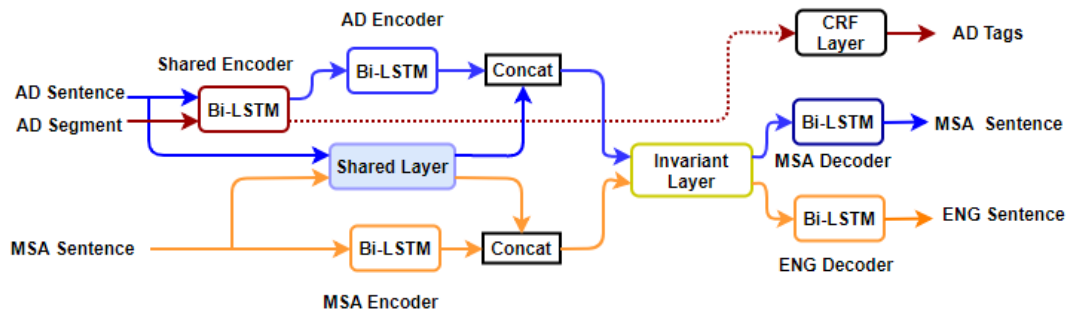
Figure 2. The Architecture of the proposed model.